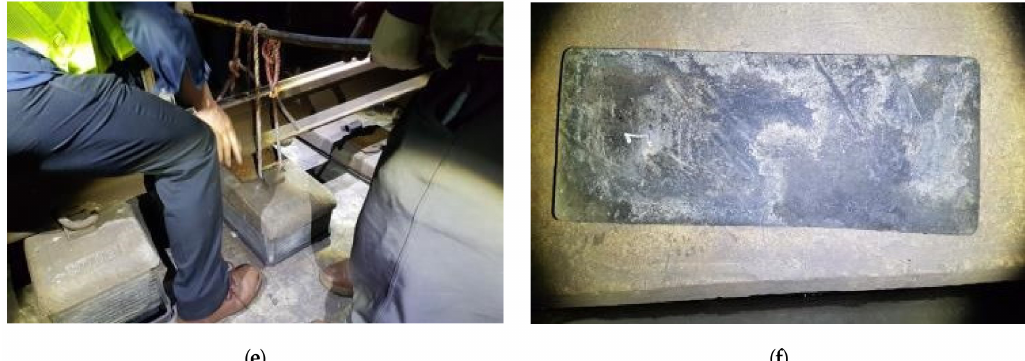
Figure 2. Photograph of collecting for used resilience pad samples. ( a ) Pre-work (Dismantling rail fastener and installation Jack-up device); ( b ) Lifting sleeper (RC block); ( c ) Positioning and separating sleeper and rubber boot; ( d ) Replacement and insertion of resilience pad; ( e ) Put the sleeper down; ( f ) Used resilience pad sample.